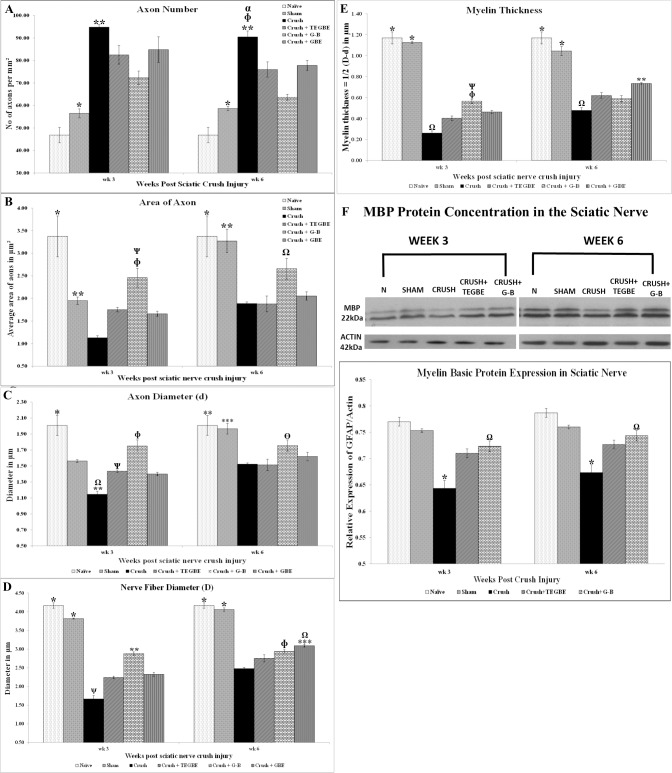
Morphometric analysis.A: Mean total numbers of myelinated axons (Number of axons/field at 1000x magnification) counted from 4 different random samples from each group used in the morphometric study. The mean total number of myelinated axons was calculated for each experimental group at week 3 and 6 following sciatic nerve injury using a 1 mm2 square counting frame. Note the all the treatments significantly decreased the number of axons/field following nerve crush injury at Week 3 and week 6. * indicates p<0.0001, sham (n = 12) vs. crush group (n = 12), TEGBE (n = 12) and GBE (n = 6) treated groups. ** indicates p<0.0001 crush vs. naive (n = 6), sham and G-B treated group (n = 12). ɸ indicates p<0.005, crush vs. TEGBE treated group. α indicates p<0.02, crush vs. GBE treated group. Values are expressed as means ±SD. B: Mean cross-sectional areas of myelinated axons obtained from 4 different and randomly selected samples from each group (3 animals/group). The averaged cross-sectional areas of myelinated axons measured in square micrometers (μm2) were calculated for each experimental group at week 3 and 6 following sciatic nerve injuries. Compared with crush group, G-B-treated animals show significantly higher in the average areas of axons per unit square among other treated groups at week 3 and 6, p<0.0001 and p<0.02 respectively. * indicates p<0.0001, naive vs. crush, TEGBE treated groups. ** indicates p<0.005, sham vs. crush group. ɸ indicates p<0.0001, G-B treated group vs. crush. Ω indicates p<0.02, G-B-treated group vs. crush and TEGBE-treated groups. Ѱ indicates p<0.005 G-B vs. GBE treated animals. The values are expressed in mean ± SDs. C, D, E: Stereological estimation of the myelinated axon diameter (C), myelinated nerve fiber diameter (D), and myelin thickness (E) obtained from 4 different random samples from each of 3 animals per group. The mean values of the axon (d) and nerve fiber (D) diameters were calculated using an image analysis software (Image Pro-Plus 6.0) for each experimental group at weeks 3 and 6 following sciatic nerve injuries using a square counting frame. C: The crush and treated groups display significantly lower in myelinated axon diameter compared to all groups compared to naive and sham animals at week 3 and week 6 post-injury, whereas the G-B-treated group display significantly high in the mean of myelinated axon diameter among other treated groups at both time points. * indicated p<0.0001, naive vs. sham, crush, TEGBE and GBE-treated groups. ** indicates p<0.0001, crush vs. naive, sham, and G-B. Ω indicates p<0.005, crush vs. TEGBE and GBE-treated groups. ɸ indicates p<0.0001, G-B-treated group vs. crush and GBE. Ѱ indicates p<0.002, TEGBE treated group vs. crush and G-B-treated groups. *** indicates p<0.0001, sham and naive vs. crush and TEGBE-treated groups. ϴ indicates P<0.03, G-B-treated group vs. crush and TEGBE-treated groups. D: The crush group displays a significant decrease in nerve fiber diameter at both time points assessed following nerve injury compared with sham and naive groups. However, G-B treated group exhibits a significantly increase in nerve fiber diameter among other groups compared to crush group at week 3 post injury. Whereas, TEGBE-treated group shows a significant increase in the nerve fiber diameter only at week 6 compared to other groups. * indicates p<0.0001, naive and sham compared to all other groups at week 3 and week 6. ** indicates p<0.0001, G-B vs. all other groups (higher than crush group, TEGBE and GBE-treated groups and lower than naive and sham groups). Ψ indicates p<0.0001, crush vs. all other groups. ɸ indicates p<0.0001, G-B treated group vs. naive, sham and crush groups. *** indicates p<0.0001, GBE vs. naive, sham and crush groups. Ω indicates p<0.02, GBE vs. TEGBE. E: The average values of myelin thickness were obtained from (D) and (d) values and calculated by the following formula: ½(D-d). The calculated myelin thickness for the crush and the treated groups (TEGBE, G-B and GBE) at week 3 and week 6 following sciatic nerve injury shows a significant decrease in a myelin thickness throughout the experiment compared to naive and sham groups. However, the myelin thickness in all treated groups increased significantly compared with crush group at week 3 and week 6 post-injury. * indicates p<0.0001, naive and sham vs. crush and treated groups with TEGBE, G-B and GBE. ɸ indicates p<0.0001, G-B-treated group vs. crush group. Ѱ indicates p<0.005, G-B-treated group vs. TEGBE treated group. ** indicates p<0.0001, GBE treated group vs. crush. Ω indicates P<0.02, crush group vs. all groups. Values are expressed as means ±SDs. F: Western blotting graph and data analysis of myelin basic protein (MBP) expression in the sciatic nerves obtained from naive, sham, crush, crush + G-B and crush + TEGBE and normalized with densities of actin band (Molecular weight-42). GBE treated group was not applied to this test due to a shortage of animal supply. In each group, sciatic nerve from three rats was analyzed. The antibody used to detect the MBP (D-18): sc-13912, Santa Cruz Biotechnology, Molecular weight-14-22) recognizes three distinct bands. Note that the MBP was significantly (*p<0.0001) decreased in crush group compared to all groups at weeks 3 and 6 following sciatic nerve injury. Also, MBP was significantly (Ω p<0.05) increased in G-B treated group compared to TEGBE treated group at both time points. Values are expressed as means ± SDs.